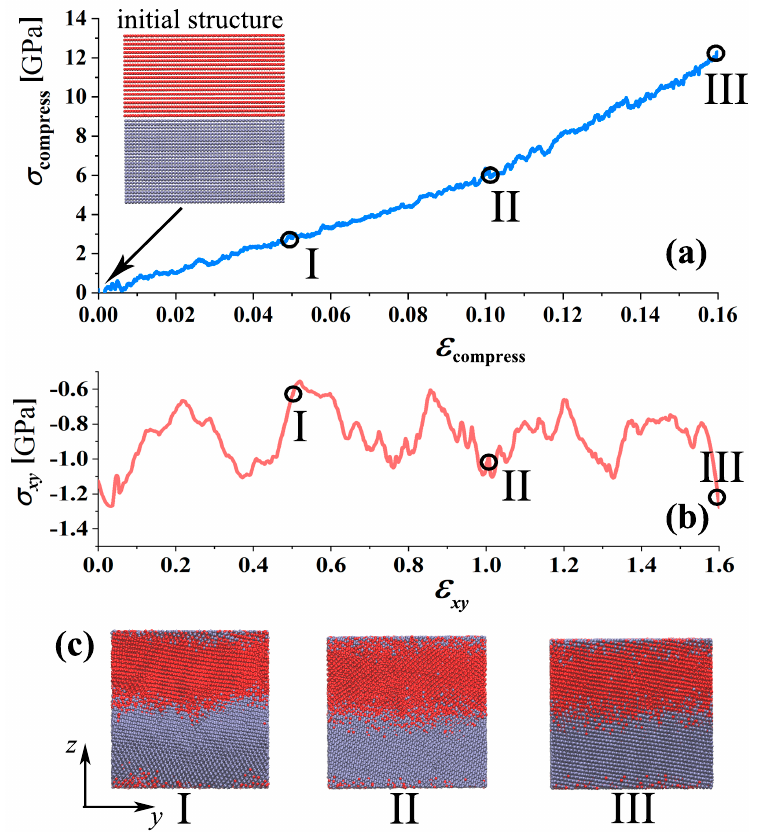
Figure 2. Stress–strain curves during uniaxial compression normal to the Al–Mg interface combined with shear: ( a ) compressive strain and stress; ( b ) shear strain and stress; ( c ) the snapshots of the structure at three stages of deformation. The red color is for Mg atoms, the blue color is for Al